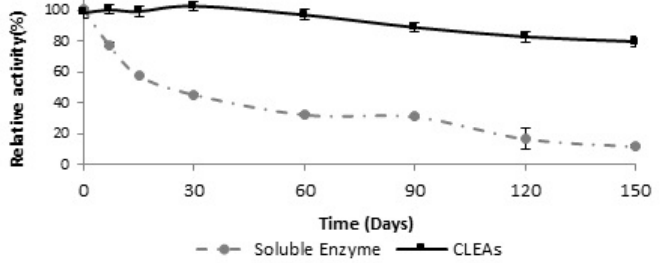
Figure 6. Storage stability of soluble and immobilized enzyme via the CLEAs technique after 150 days at 4 °C.